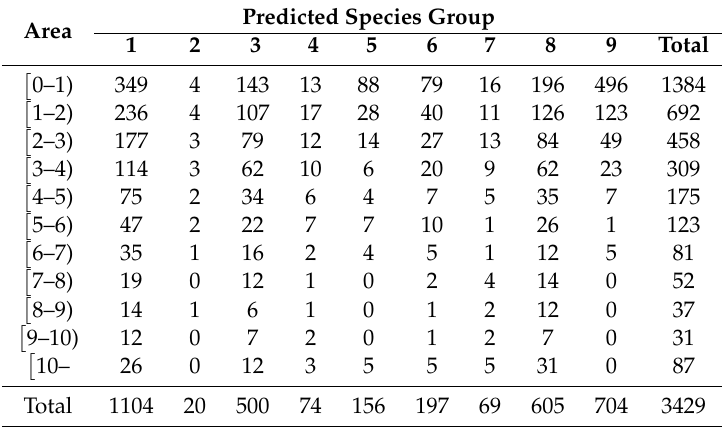
Table 9. The number of the parcels by the area classes (ha) and species group prediction.